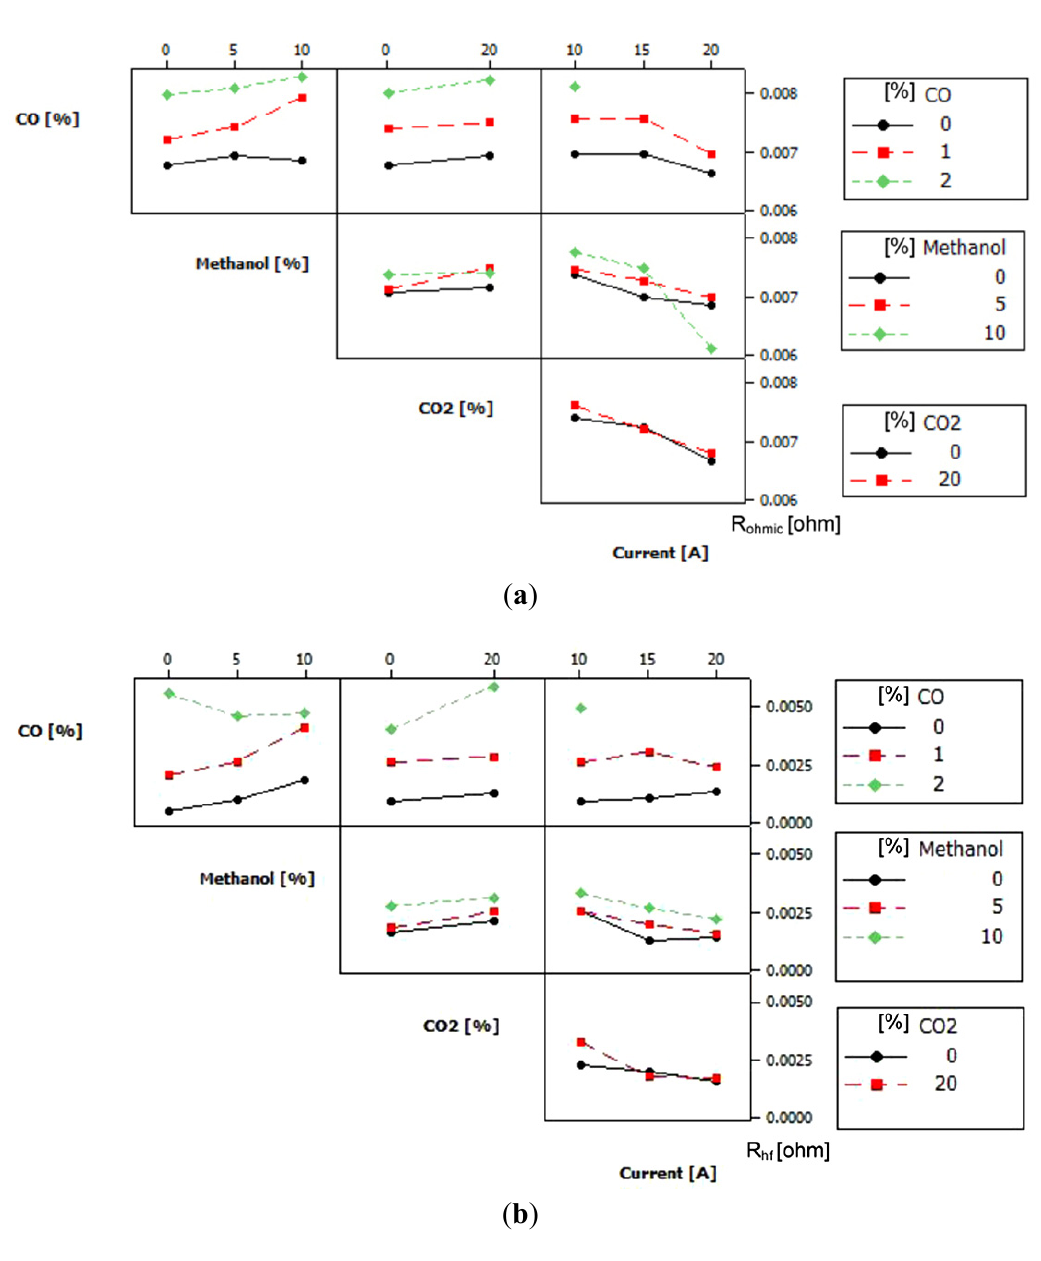
Figure 5. Interaction of effects among the different factors at 160 °C. ( a ) Ohmic resistance; ( b ) High frequency resistance; ( c ) Intermediate -low frequency